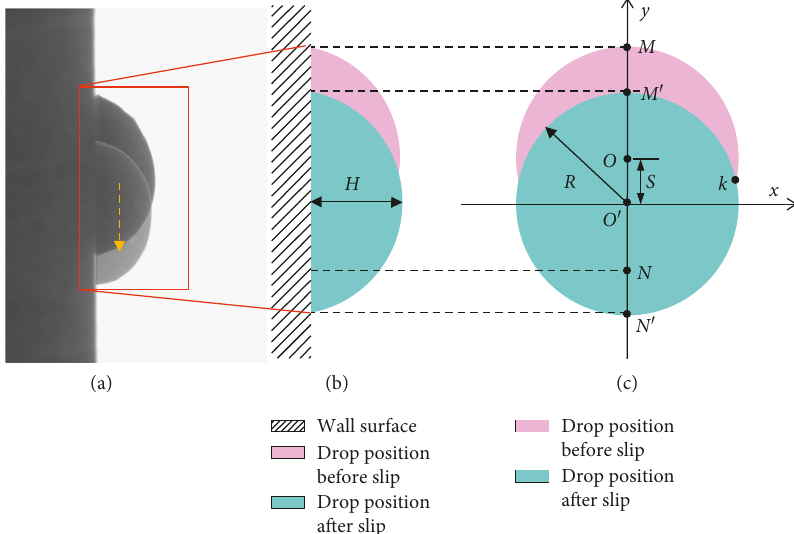
Figure 3: Droplet on a wall sliding/losing adhesion. (a) Real slurry sliding away from the wall and losing adhesion. (b) Slide away from wall and lose adhesion model. (c) Analytical geometry of the model.